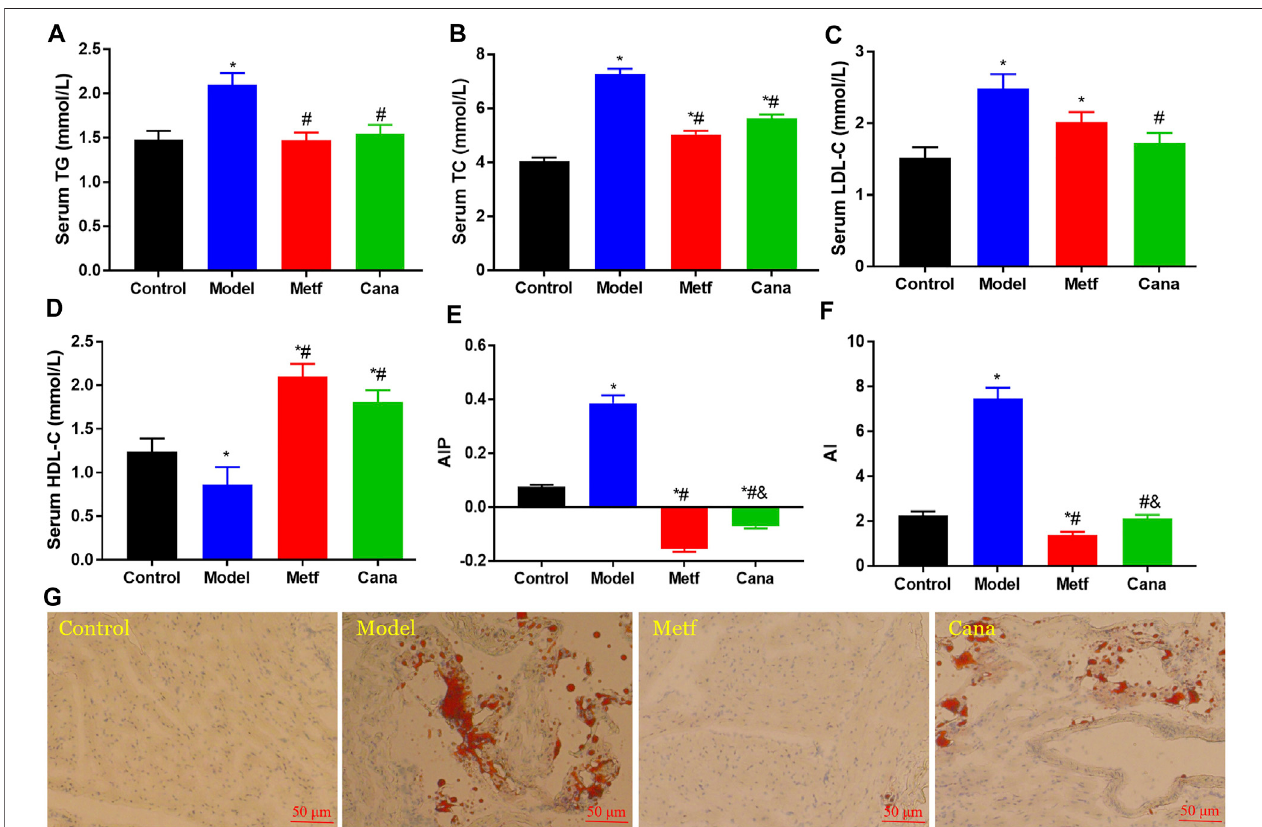
FIGURE 1 | Effects of canagli fl ozin (Cana) on lipid pro fi le in type 2 diabetes mellitus (T2DM) mice. Triglyceride (TG) (A) , total cholesterol (TC) (B) , low-density lipoprotein cholesterol (LDL-C) (C) , and high-density lipoprotein cholesterol (HDL-C) (D) levels in serum. Atherogenic index of plasma (AIP) (E) , calculated by lg(TG / HDL-C). Atherogenic index (AI) (F) , calculated by (TC − HDL-C) / HDL-C. Cardiac tissues with Oil Red O staining (G) . Data are expressed as mean ± SEM. & p < 0.05, the Cana group compared with the Metf group; # p < 0.05, compared with the model group; * p < 0.05, compared with the control group. Six mice in each group were randomly selected, and statistical analyses were